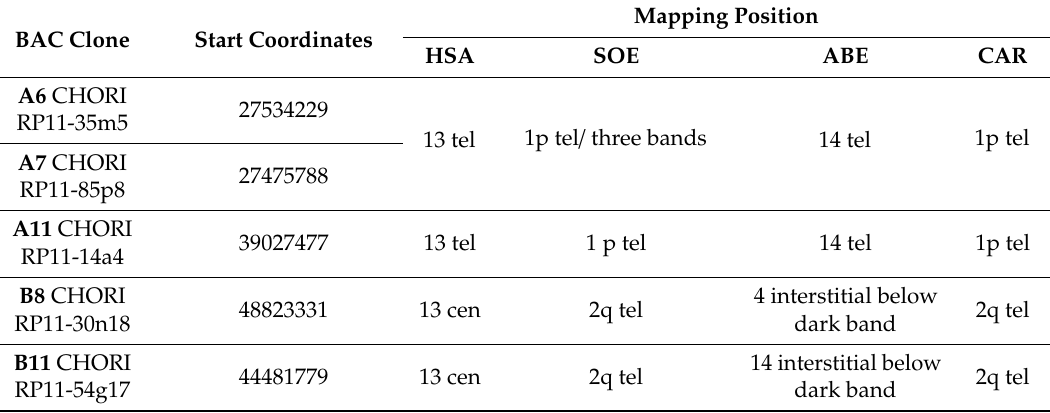
Table 3. The list of Bacterial Artificial Chromosome (BAC) clones used with their chromosome start coordinates and mapping position in the human genome from the UCSC genome browser (GRCH 37 / Dec 2004) and the mapping position obtained on the three species analysed: S. oedipus (SOE), C. argentata (CAR), A. belzebul